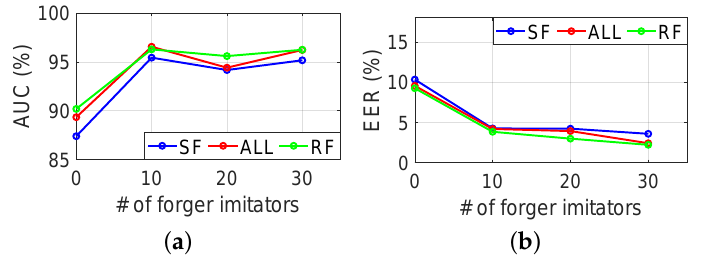
Figure 11. ( a ) AUC abd ( b ) EER under a various number of forger imitators included in the model training.